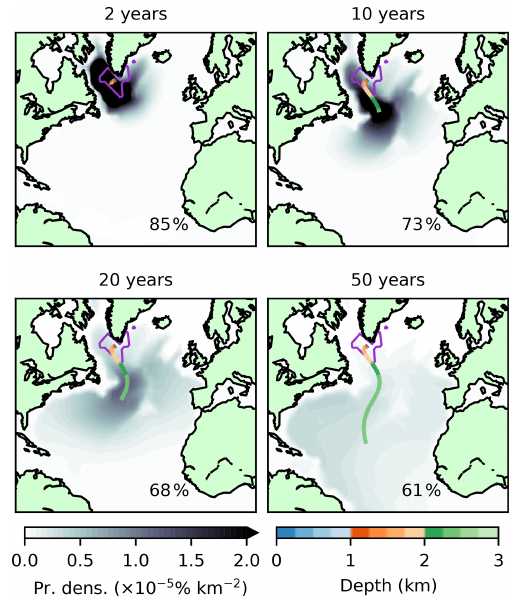
Figure 11. As in Fig. 6 but for subpolar-outcropping model NADW and times of 2, 10, 20, and 50